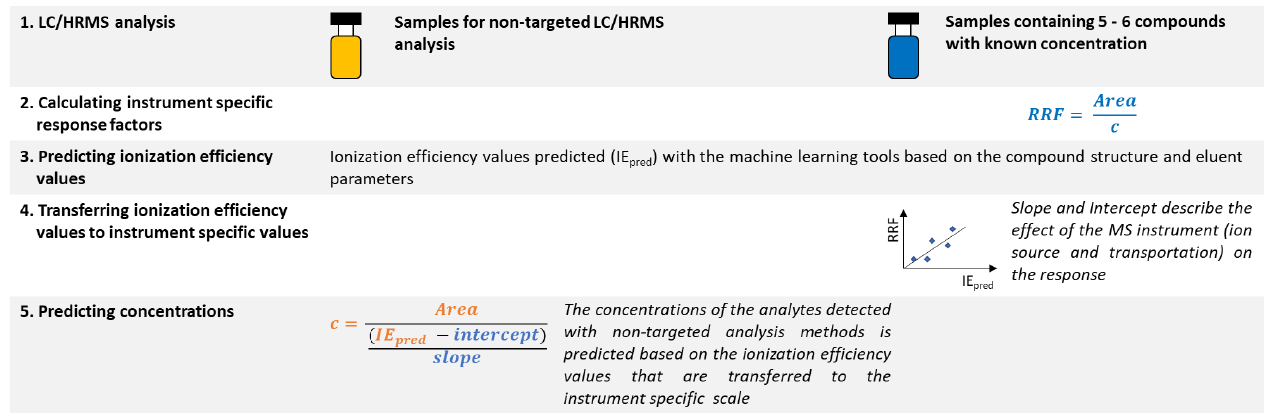
Figure 8. Workflow for using predicted ionization efficiencies for the quantification of compounds discovered in non-targeted analysis, accounting for the structure of the compound, the eluent composition, as well as instrument-specific aspects. [143] Adapted with permission [143] Copyright 2020 American Chemical Society.